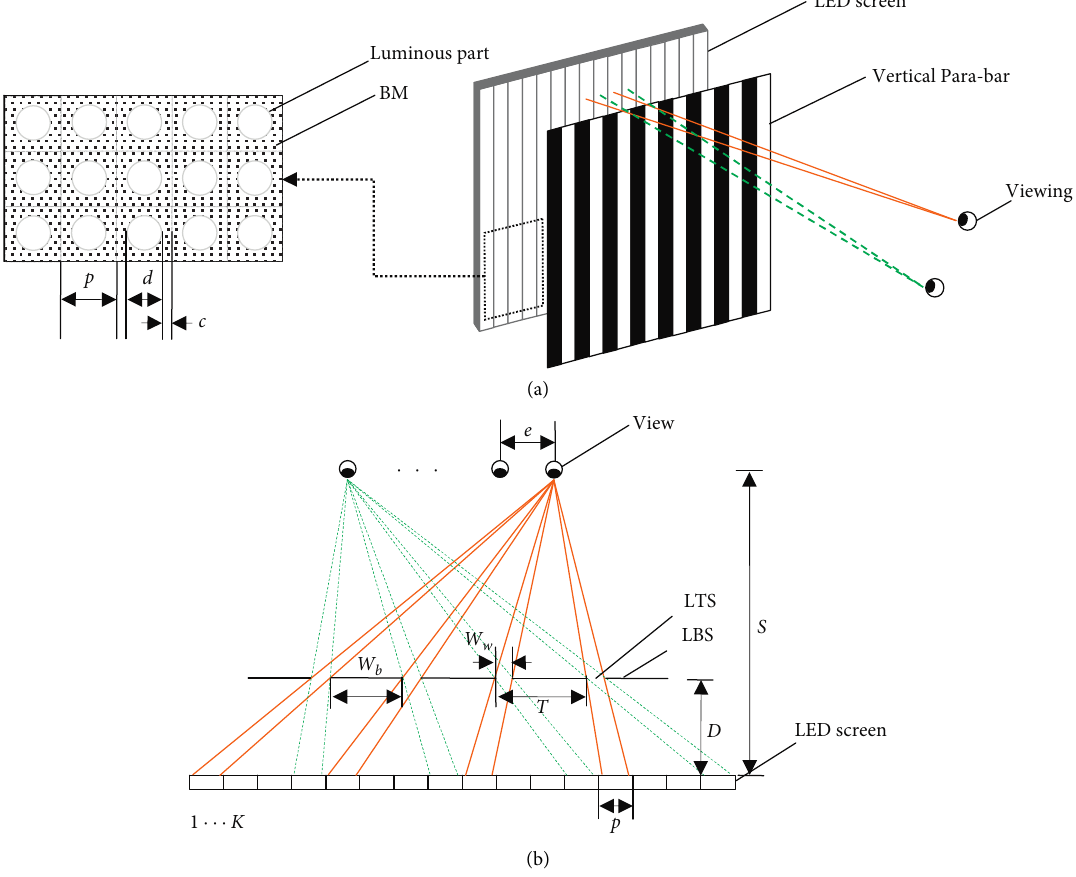
Figure 1: Naked-eye 3D display based on the parallax barrier. (a) Structure; (b) principle of beam